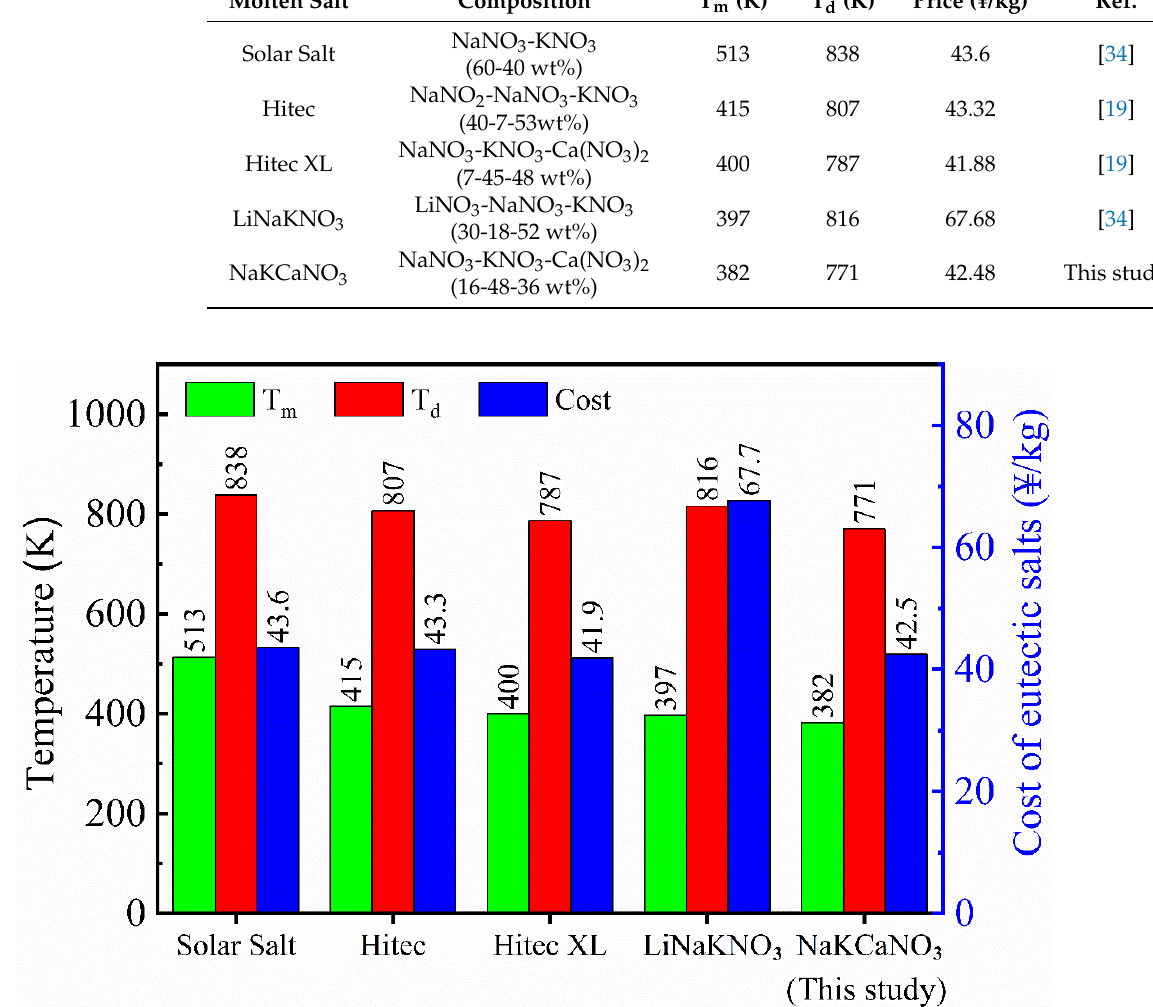
Figure 12. Melting point (T m ), decomposition temperature (T d ), and cost of the NaNO 3 -KNO 3 -Ca(NO 3 ) 2 (16:48:36 wt%) eutectic ternary salt and four other generally used nitrate/nitrite